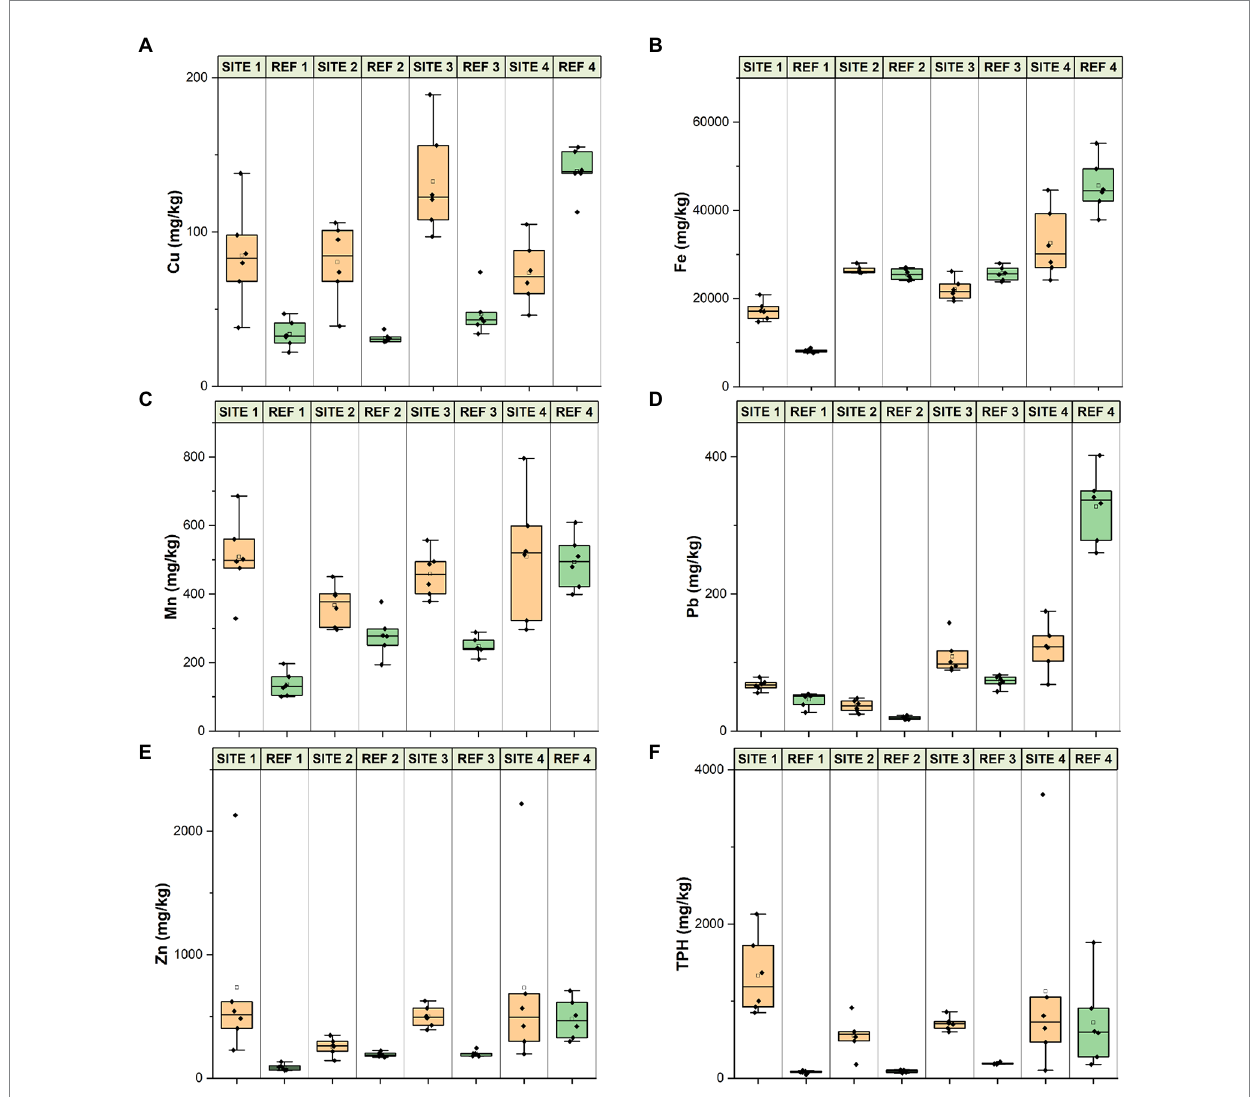
FIGURE 3 Concentrations of a range of potential pollutants between underpass sites (orange) and respective reference sites (green). (A) Copper; (B) Iron; (C) Manganese; (D) Lead; (E) Zinc; (F) Total Petroleum Hydrocarbons. All values in mg/kg dry weight sediment. Data show raw data points as dots, with 95 th percentile, interquartile range and median shown by